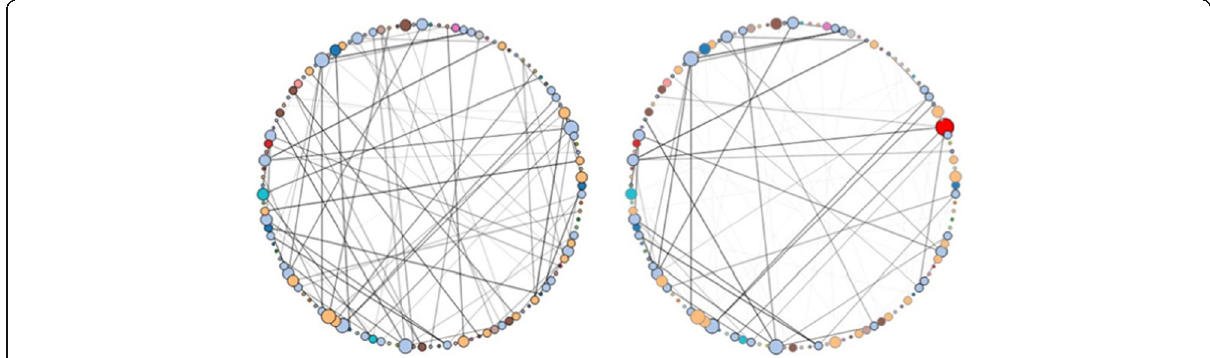
Fig. 3 Radial layout of node-link diagram of randomly generated dataset. Left: Initial radial layout; Right: Filtered radial layout [16]